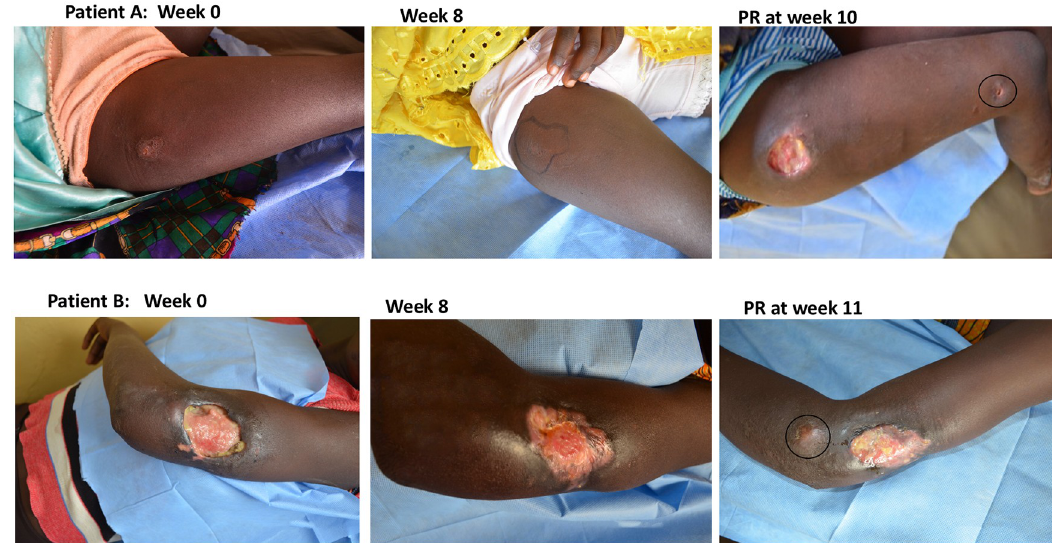
Fig 4. Images of 2 patients (A and B) who had positive 16S rRNA and culture results after 8 weeks of antibiotic treatment. Patient A; Presented with a plaque on the right thigh with surrounding induration (week 0) which reduced significantly after antibiotic treatment (week 8). A new lesion appeared on the right knee at week 10 at the same time as the original lesion on the right thigh re-ulcerated (PR at week 10). Patient B; Presented with an ulcer on the left elbow (week 0), there was improvement after antibiotic treatment as evidenced by formation of clean granulation tissue with some epithelization (week 8). A new lesion was seen close to the initial lesion (PR at week 11).